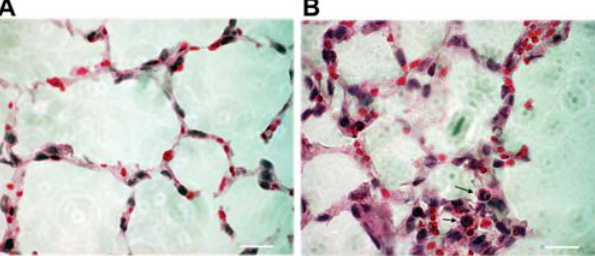
Figure 3. Mechanical ventilation-induced neutrophil leukocyte infiltration in lung tissue. (A) Control (non-ventilated) lung tissue. (B) Mechanical ventilation-induced lung injury following mechanical ventilation (10 ml/kg, 8 hours). Arrows point at mononuclear leuko- cytes in the alveoli. Hematoxylin-eosin staining, 40-fold magnification, scalebar=50 micrometer. A representative picture is